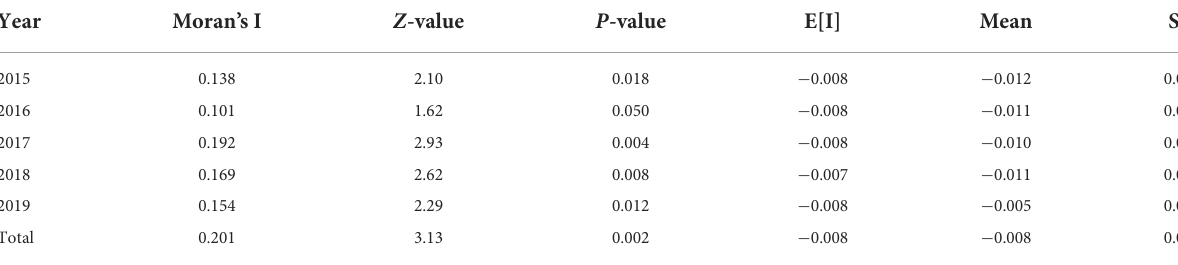
TABLE 2 Global spatial autocorrelation of liver cancer mortality in Yunnan,